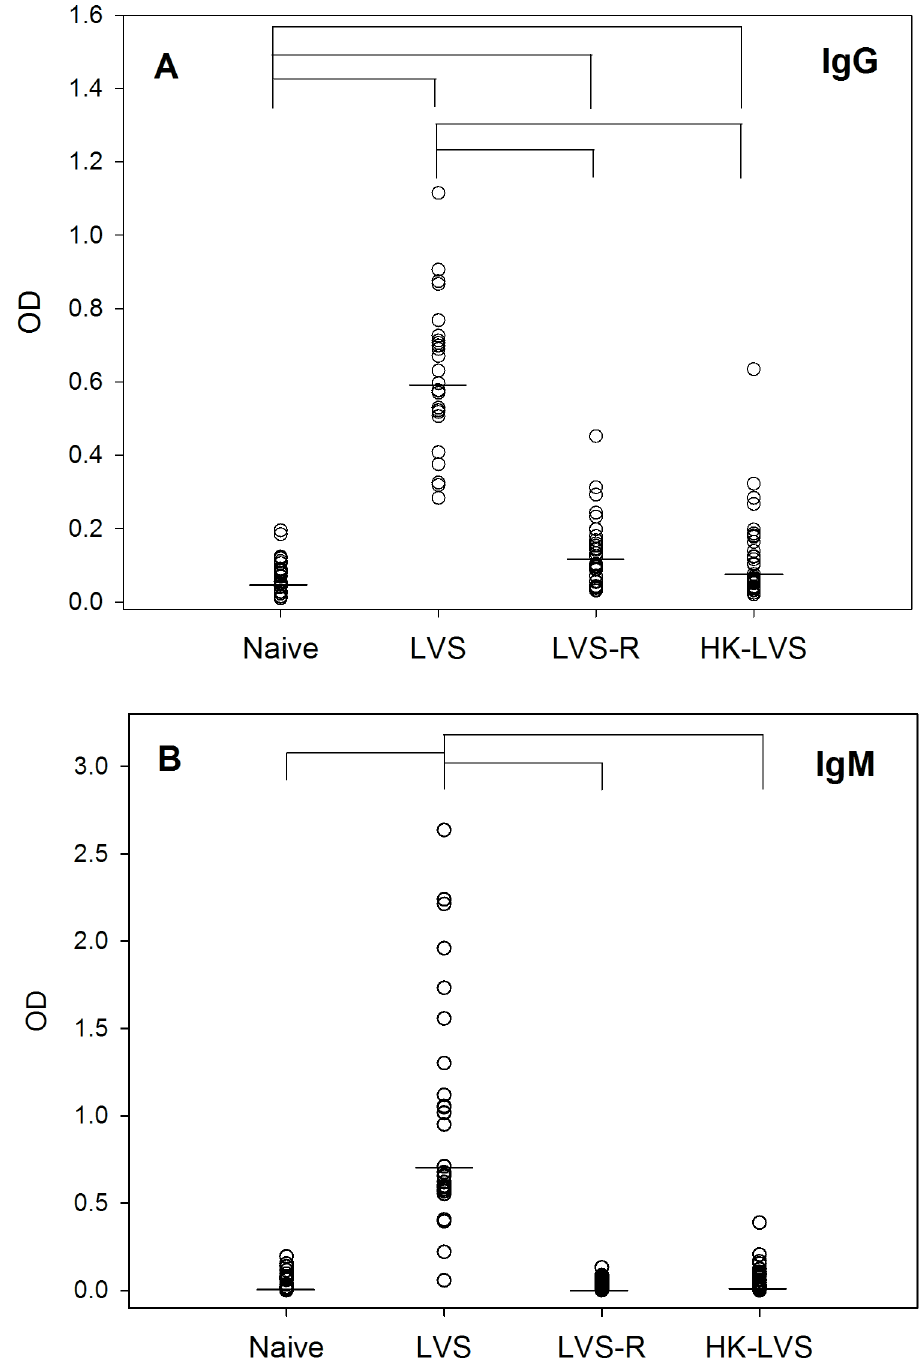
Fig 5. LVS-vaccinated rats exhibit humoral immune responses. Sera from individual rats were obtained 2–3 weeks after vaccination and analyzed for anti-LVS total IgG (Panel A) and IgM (Panel B) antibodies. Sera from four sets of vaccinations were tested for a total of 27–35 sera for each vaccine group. Shown are the OD values obtained at a 1:1600 dilution for each individual serum; lines indicate median values for the group. Brackets indicate significant differences ( P < 0.05) between the indicated antibody